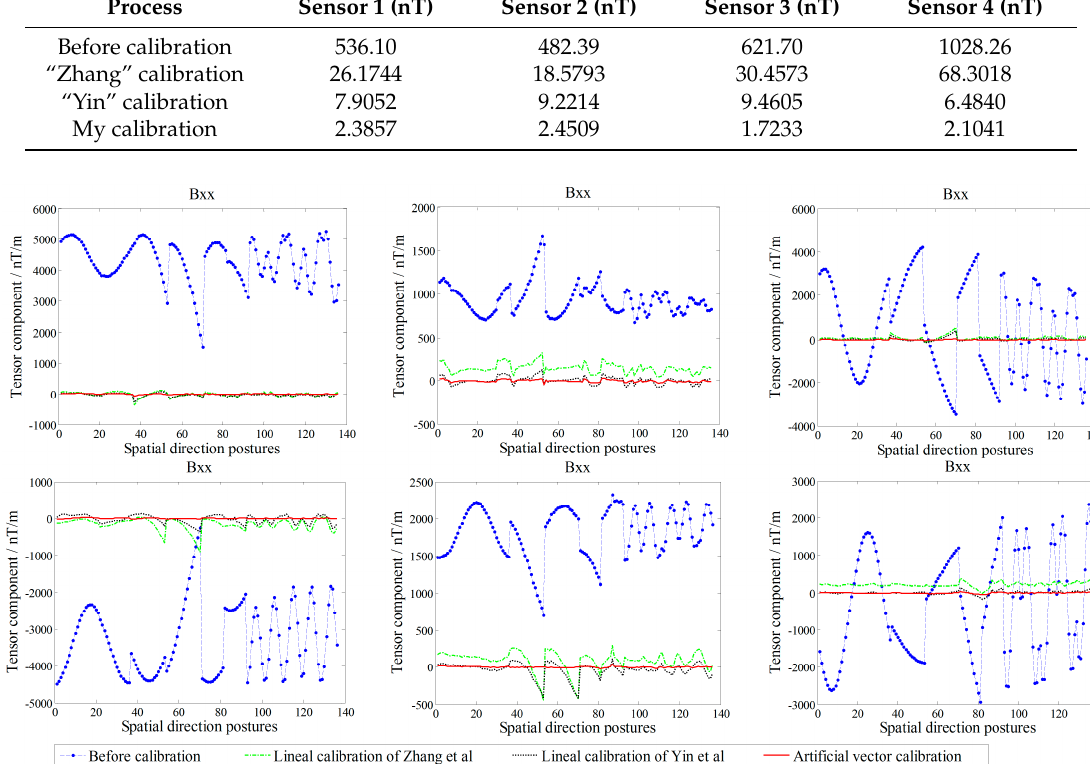
Figure 11. Spatial distributions of tricomponents before and after calibration of the first 36 orientations. To verify the robust performance of the 48 error parameters estimated by this method, we reselect the measurement point. The obtained results show that the reproduction degree of each parameter after two estimation iterations is higher than 95% in Table 6, indicating that the calibration results are stable and reliable.